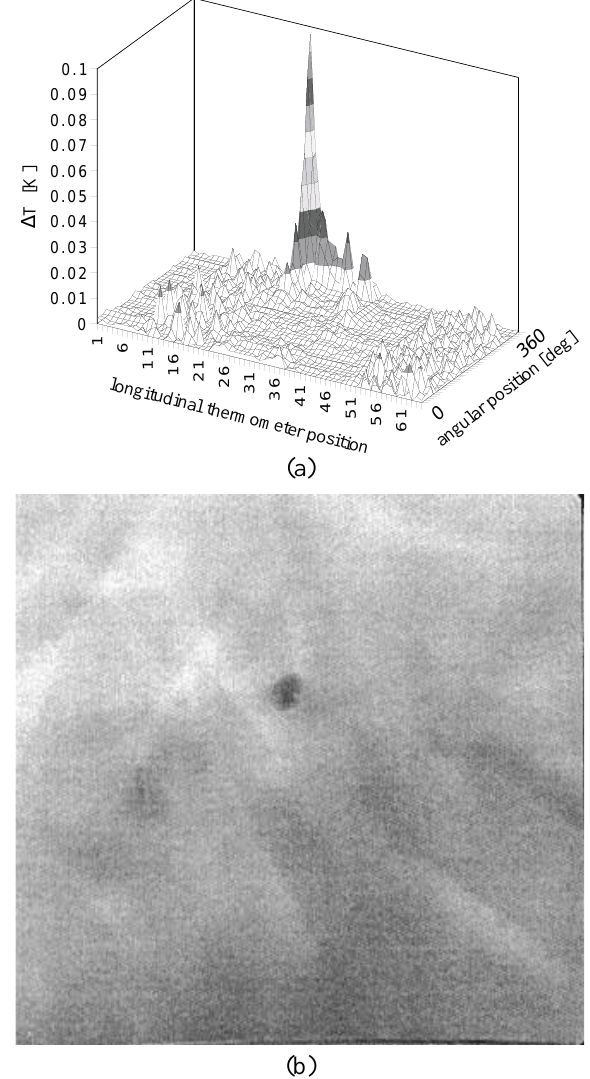
FIG. 16. (a) Temperature map of cell 5 of cavity C6 showing excessive heating at a localized spot. (b) Positive print of an x-ray radiograph showing the “hot spot” as a dark point.